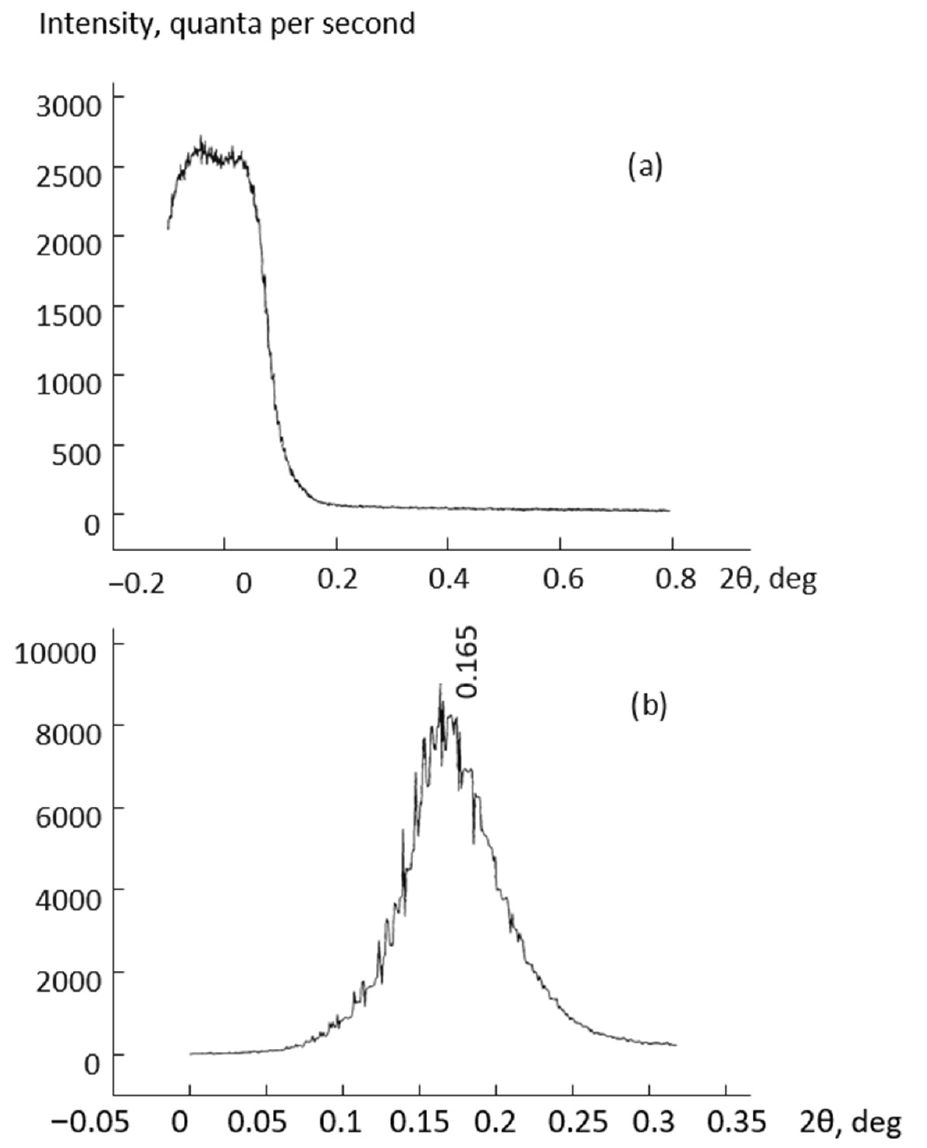
Figure 1. Silicon single crystal (111) with a face-centered lattice: ( a ) integral curve of TER; ( b ) differential curve of TER with an indication of an angle of 2 θ degrees above the maximum [18]. The differential radiograph of TER for polished tantalum, shown in Figure 2, showed two maxima corresponding to two different refractive indices of